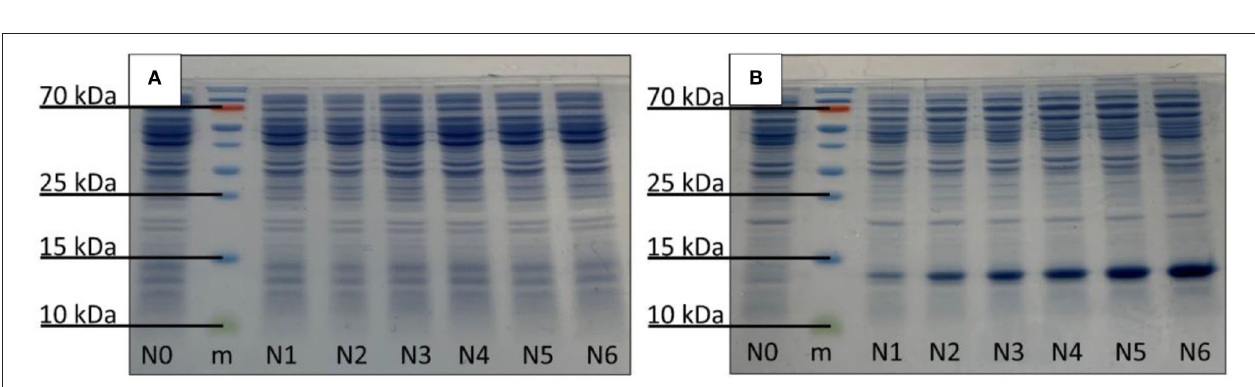
FIGURE 3 | Detection of Cyt b 5 production via SDS–PAGE analysis: (A) control and (B) thermally induced E. coli N4830-1 strains, N0–N6 carrying 0–6 copies of Cyt b 5 gene, respectively. The protein marker is labeled as